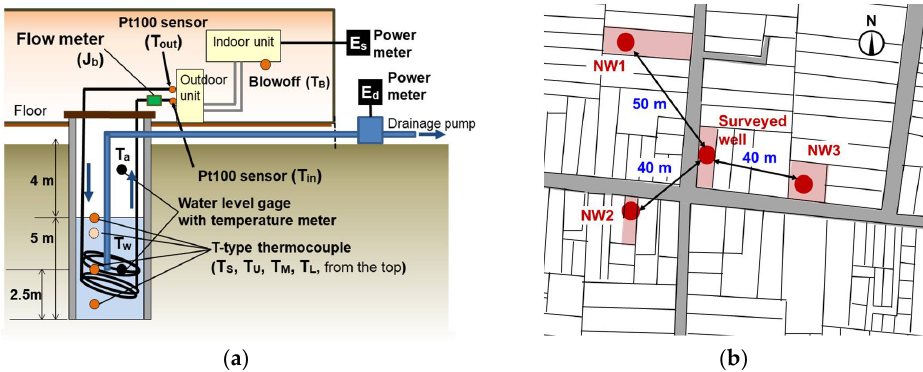
Figure 3. Measurement points. ( a ) Schematic of the measuring points and equipment. ( b ) Location of neighborhood wells (NWs). T S : well-water temperature close to the water surface; T L :